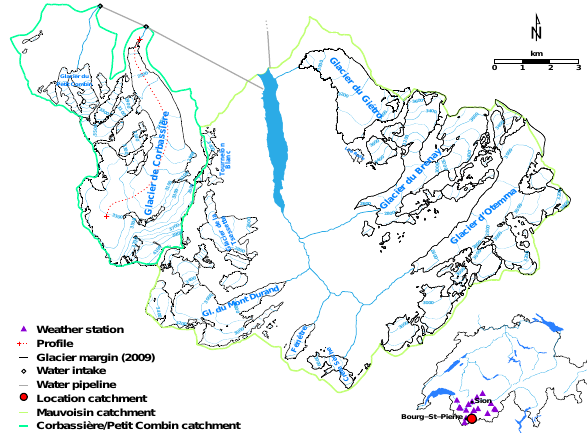
Fig. 1. Overview of the Mauvoisin region. The inset on the bottom right shows the location of the catchment within Switzerland and the weather stations used in this study. The red dashed line refers to the profile of Fig.